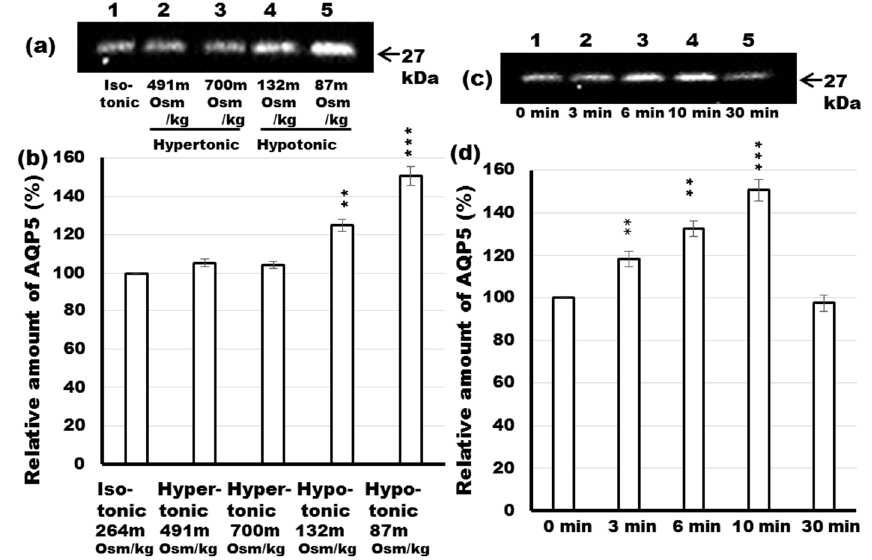
Figure 6. Effect of hypotonicity or hypertonicity on the translocation of AQP5 in rat parotid glands. ( a ) Tissue slices from rat parotid glands were incubated for 10 min at 37 °C in isotonic (lane 1), hypertonic (lanes 2 and 3) and hypotonic (lanes 4 and 5) solutions. Hypertonic and hypotonic solutions were made by addition of higher tonicity solution and by dilution with water, respectively. The 5 µ g of APM fraction protein was loaded on SDS-PAGE and processed by immunoblot analysis with anti-AQP5 antibody; ( b ) Densitometric analysis was carried out normalizing to total protein amount by staining membrane with Ponceau S solution and values were expressed as a percentage of the control. The membrane stained with Ponceau S was shown in Figure S1. Values are expressed as mean ˘ SE of three to six independent experiments; ( c ) Parotid tissue was incubated for 0, 3, 6, 10, and 30 min in hypotonic solution (87 mOsm/kg) (lanes 1–5). At the designated times, the tissue was homogenized, the APM was isolated and 5 µ g of sample was subjected to immunoblot analysis with anti-AQP5 antibody; ( d ) Densitometric analysis was carried out normalizing to total protein amount by staining membrane with Ponceau S solution and values were shown as a percentage of the control. The membrane stained with Ponceau S was shown in Figure S1. Values are expressed as